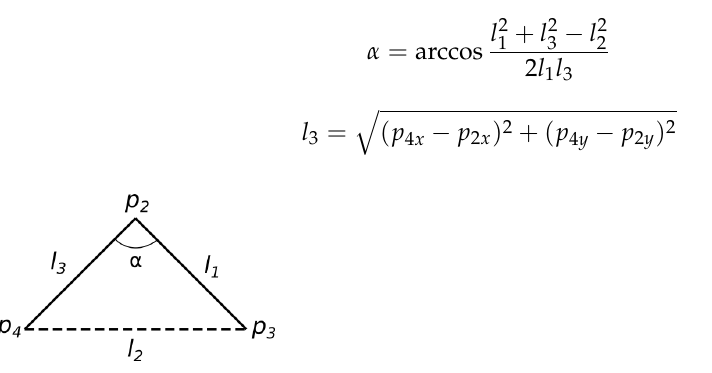
Figure 3. Example of triangle formed by 2 edges of the emotional mesh